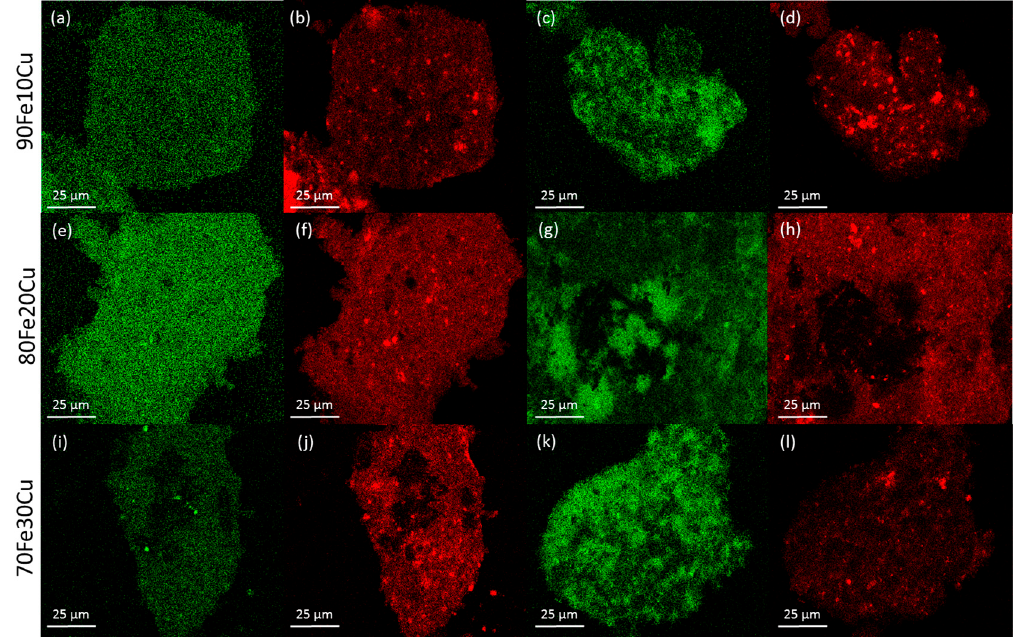
Figure 3. SEM-EDS mapping data where copper is labeled green and iron is labeled